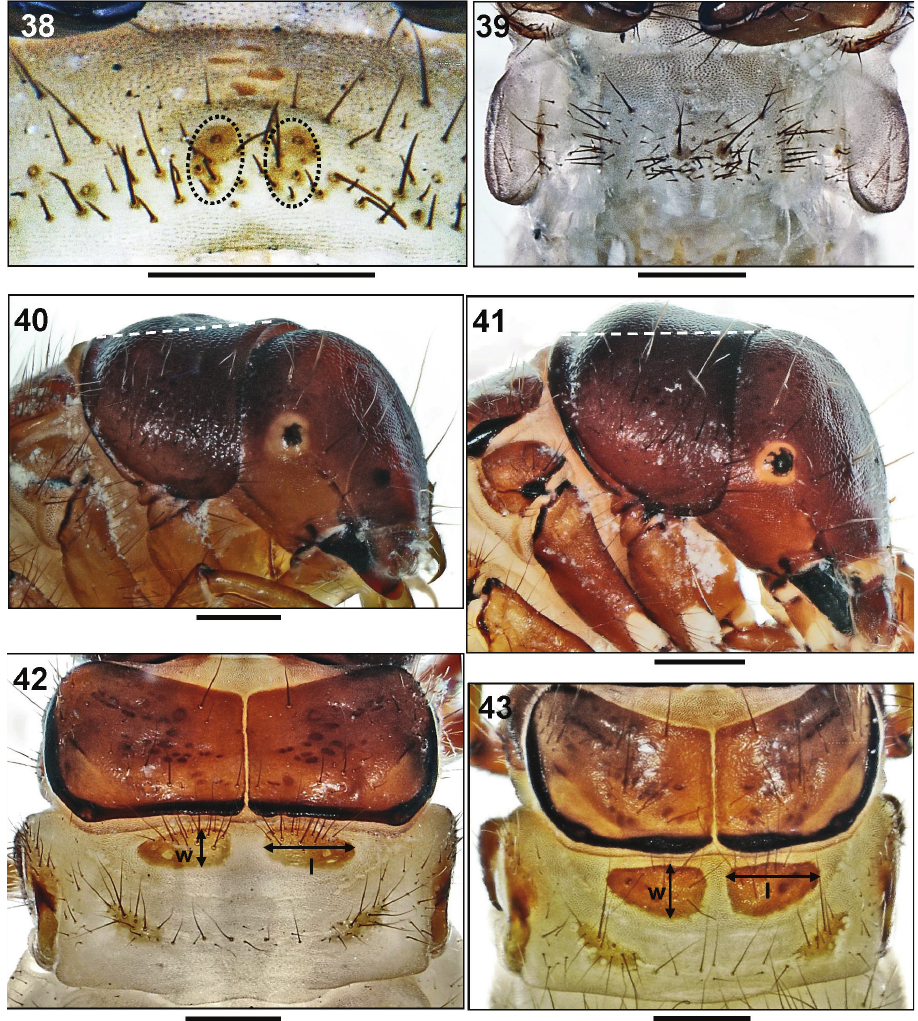
Figures 38–43. 38–39. Abdominal sterna I of 5 th instar larvae, ventral views. 38 Drusus camerinus Moretti, 1981 (dotted ovals: fused setal bases) 39 Drusus aprutiensis Moretti, 1981. 40–41. Heads and pronota of 5 th instar larvae, right lateral views. 40 Drusus aprutiensis Moretti, 1981 (dotted line: base of flat pronotal hump) 41 Drusus croaticus Marinkovic-Gospodnetic, 1971 (dotted line: base of high prono- tal hump). 42–43. Meso- and metanota of 5 th instar larvae, dorsal views. 42 Drusus croaticus Marinkovic- Gospodnetic, 1971 (w: width, l: length of anterior metanotal sclerite) 43 Drusus mixtus (Pictet, 1834) (w: width, l: length of anterior metanotal sclerite). Scale bars: 0.5